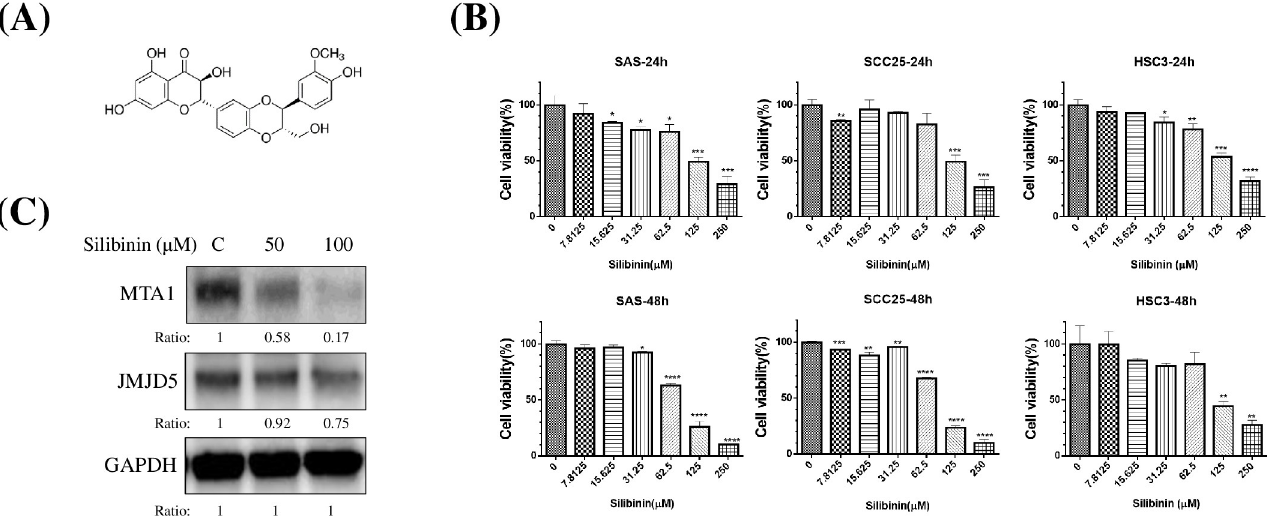
Fig 4. Silibinin inhibited the oral cancer growth and downregulated both JMJD5 and MTA1. (A) Structure of silibinin. (B) Silibinin inhibited the oral cancer cell growth in a time- and dose-dependent manner ( P < 0.05). (C) Silibinin inhibited the expression of both JMJD5 and MTA1 in SAS cells at 48hrs. The ratio was assessed as the ratio of densities of corresponding protein bands and quantification with Image J software.